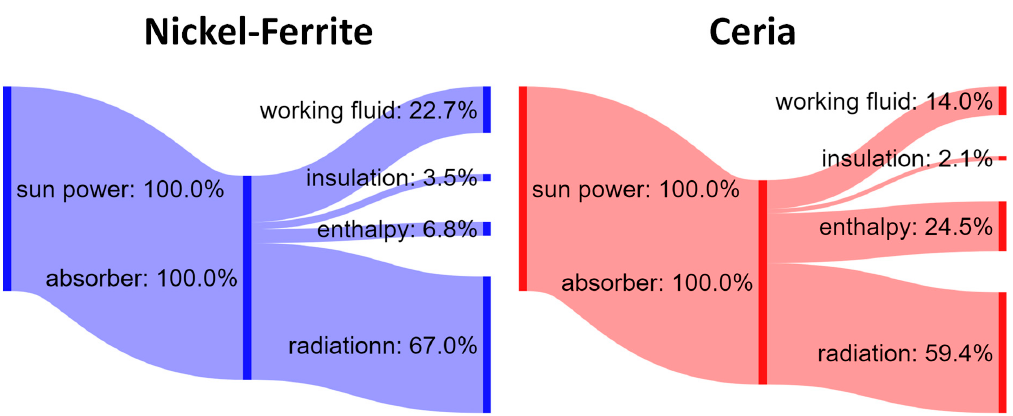
Figure 6. Sankey diagrams for nickel-ferrite (left) and ceria (right) for a full cycle.